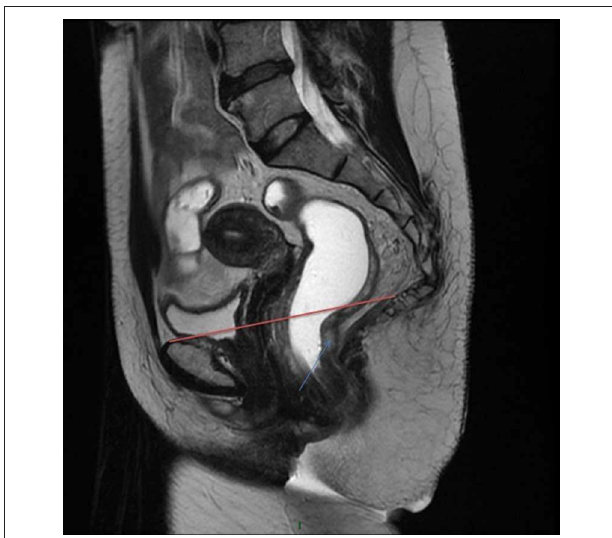
FIGURE 2 | Definition of the low rectum on MRI. On this sagittal view in a MRI T2 sequence, the low rectum begins below the red line the origin of the levator muscles and the pubic bone.